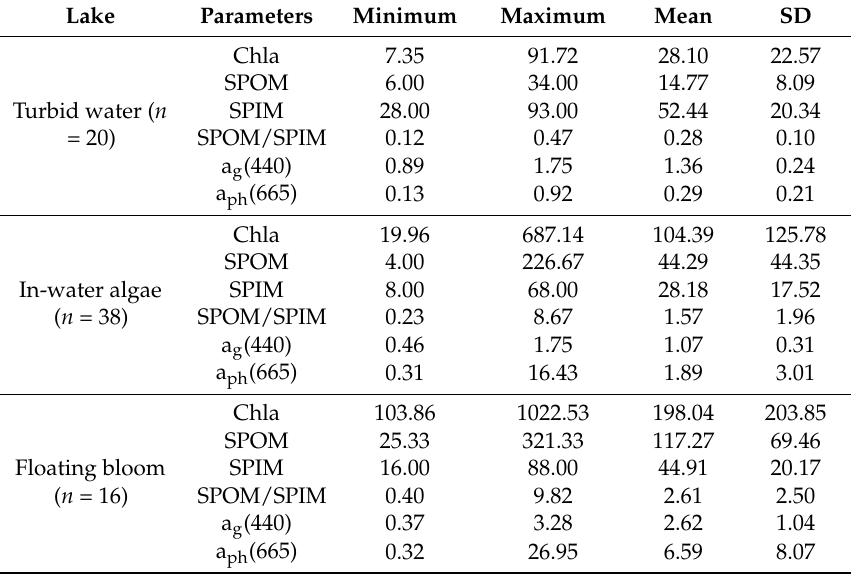
Figure 3. Average (solid line) and standard deviation (shadow) of R rs for water types: turbid water ( a ), in-water algae ( b ), and floating bloom ( c ). Table 4. Variations in bio-optical properties of three water types (turbid water, in-water algae, and floating bloom). The unit for Chla is µ g/L. The units for SPOM and SPIM are